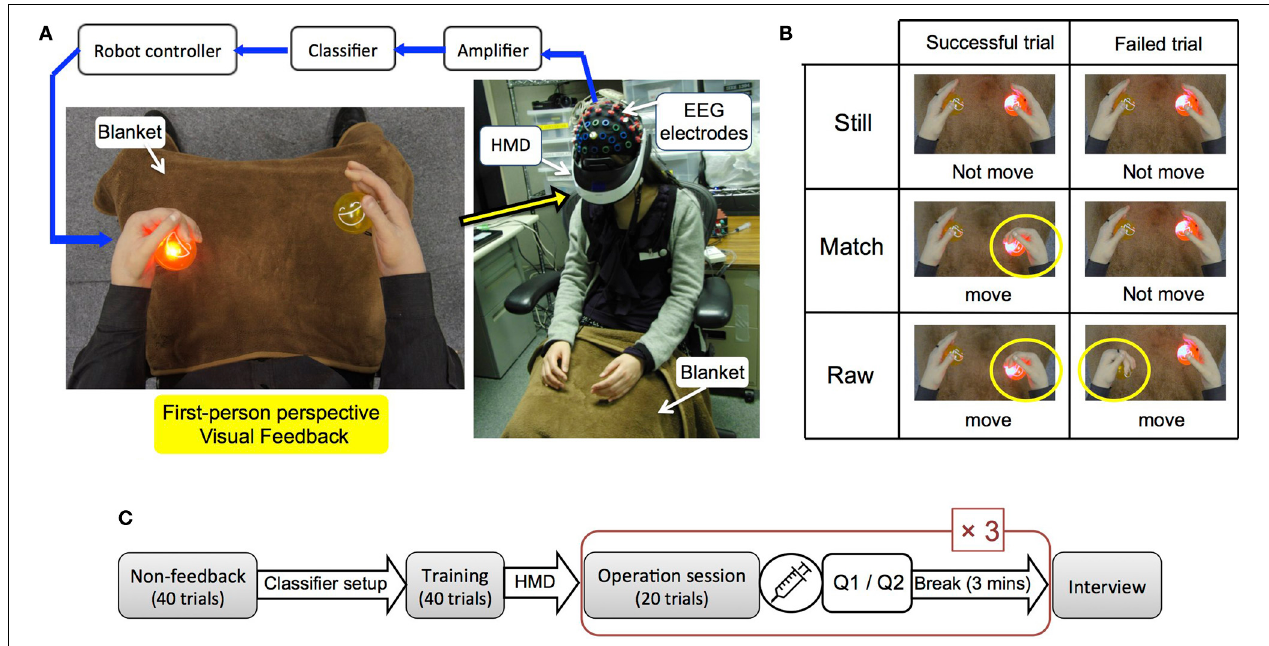
FIGURE 1 | Experiment setup. (A) EEG electrodes installed on a subject’s sensorimotor cortex recorded brain activities during a motor imagery task. Subjects watched first-person images from a robot’s perspective through a head mounted display. A lighting ball in front of each of the robot’s